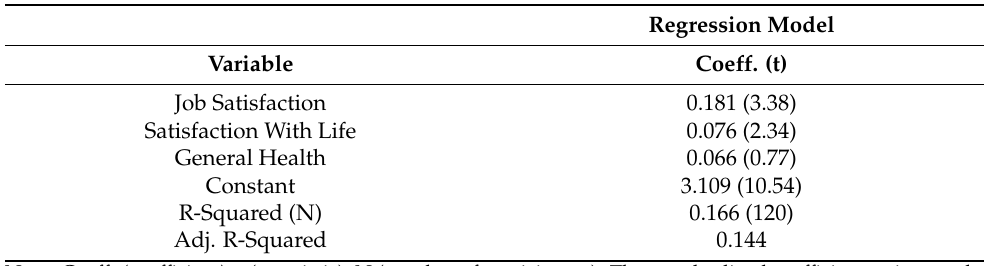
Table 3. Regression analysis between one dependent (EPQ) and three independent variables results (GHQ, JSQ, and